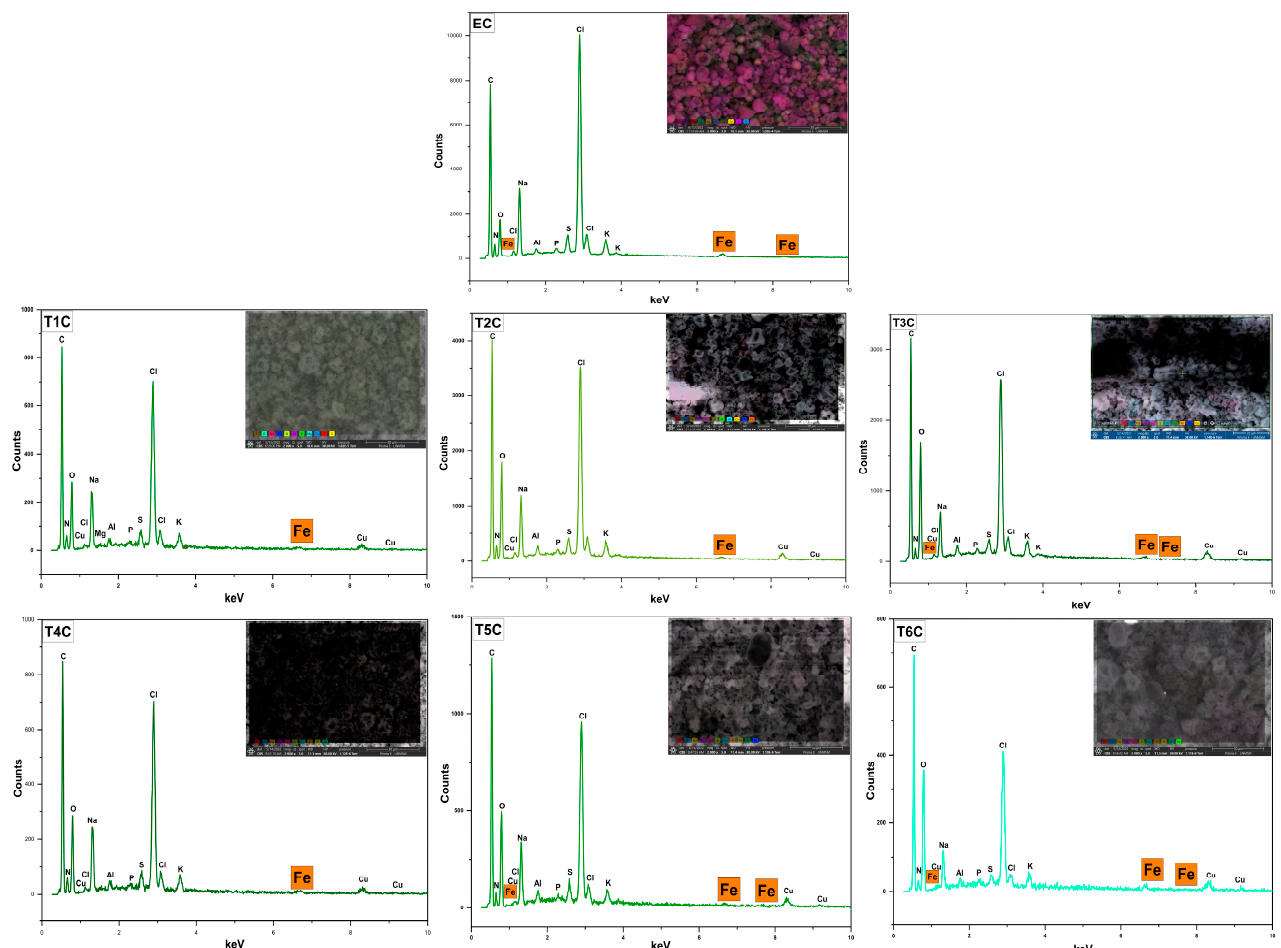
Figure 6. SEM-EDX analysis of erythrocytes (EC), encapsulated at 120 ◦ C (T1C, T2C, and T3C) and 140 ◦ C (T4C, T5C, and